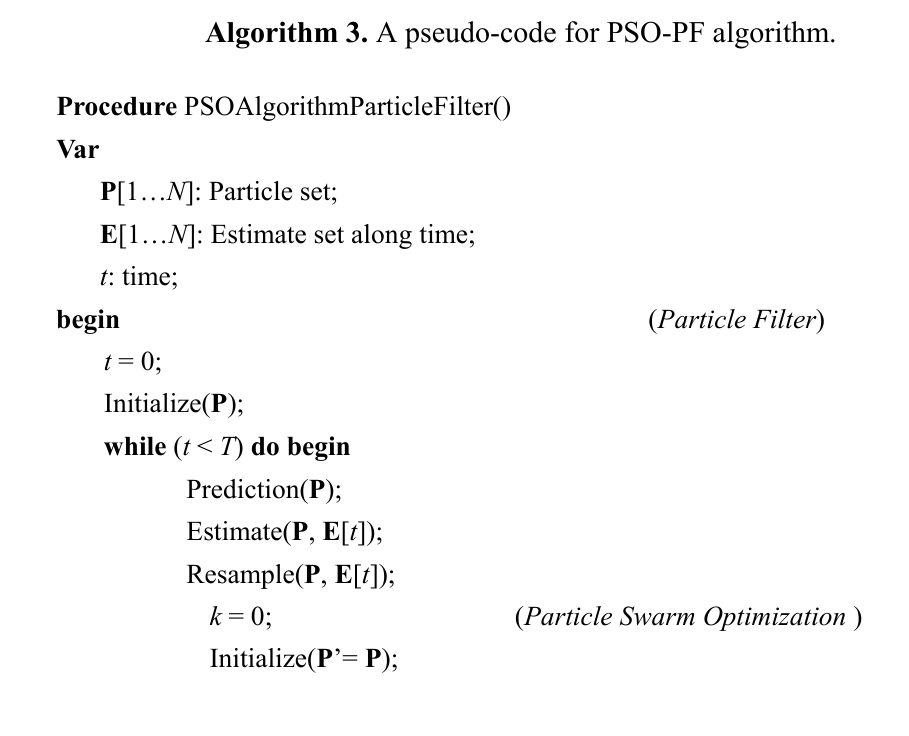
Algorithm 3. A pseudo-code for PSO-PF